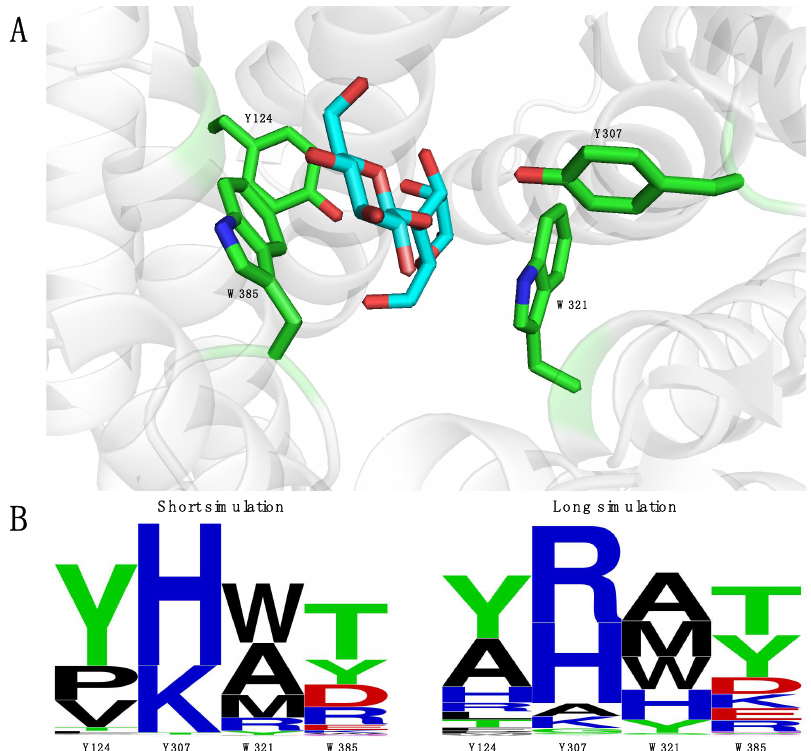
Figure 3. ( A ) Active site representation of Rm CE (PDB code: 3WKG) displaying the four residues (Tyr-124, Tyr-307, Trp-321, Trp-385) that were targeted for mutagenesis [10]. The substrate glucosylmannose is colored by element cyan (carbon in cyan, oxygen in red) while the residues were colored by element green (carbon in green, oxygen in red, nitrogen in blue). ( B ) Sequence motifs for both the short simulation and long simulation mutant library. Motifs were created by the online software Weblogo [29].